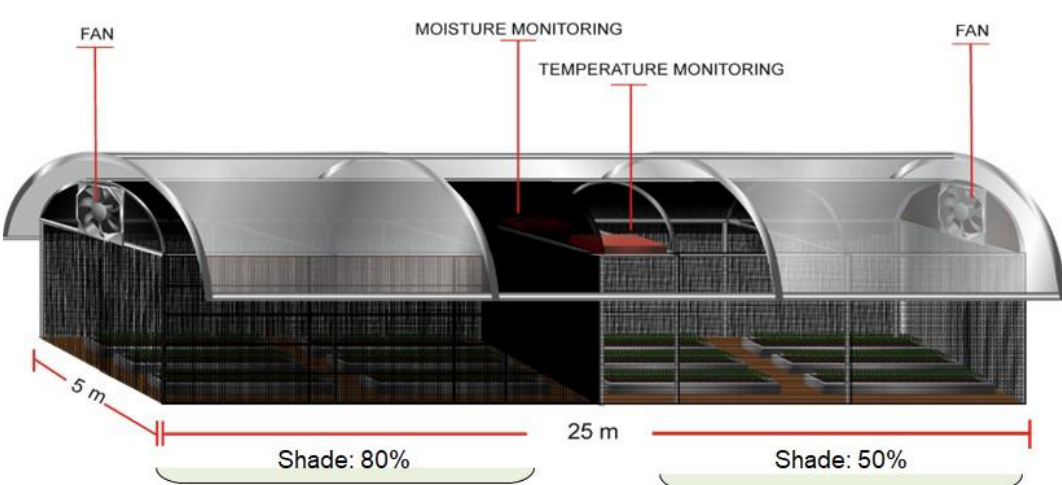
Figure 1. Greenhouse constructed at the Tropical Crops Institute (ICT), Tarapoto, Peru to evaluate the response of 58 cacao genotypes to two levels of shade: 50% (PPFD of 1000 ± 50 μmol m −2 s −1 ) and 80% (PPFD of 400 ± 50 μ mol m −2 s −1 ).